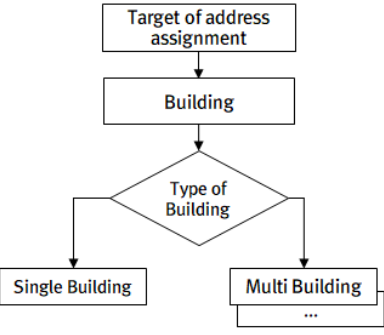
Figure 3. The process of choosing an address assignment